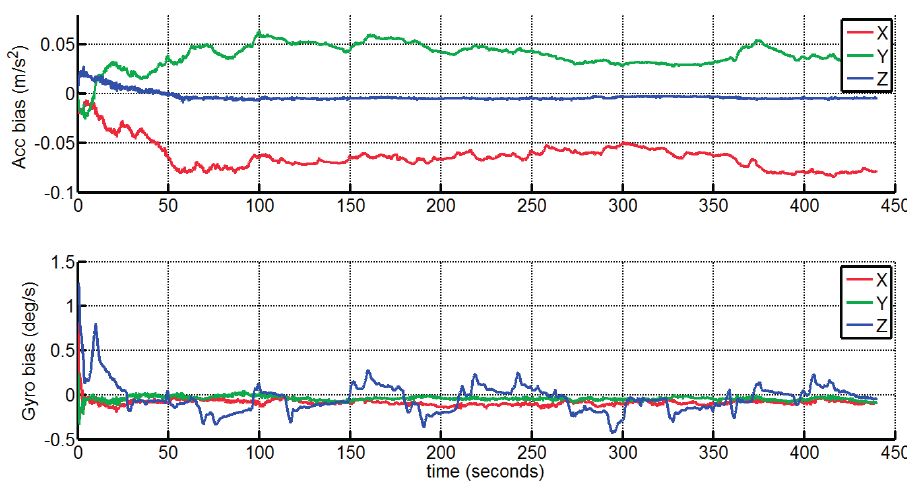
Figure 7. Estimated gyroscope and accelerometer